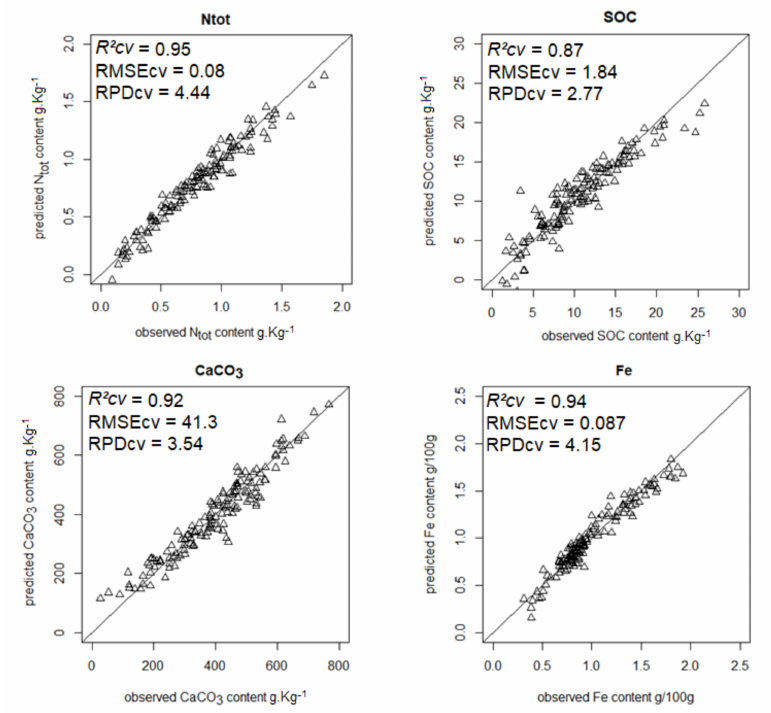
Figure 1. Scatterplots of predicted vs. observed Ntot, SOC, CaCO 3 , and Fe contents from model